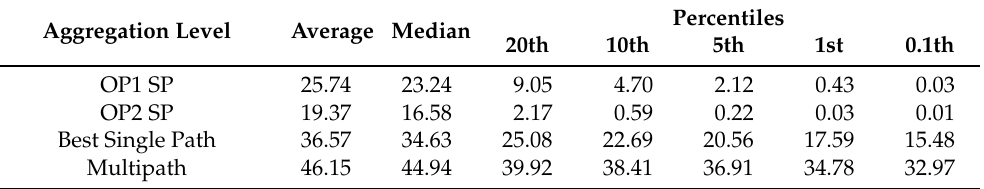
Table 3. Average capacity (in Mbps) over the whole dataset assuming different levels of aggregation.